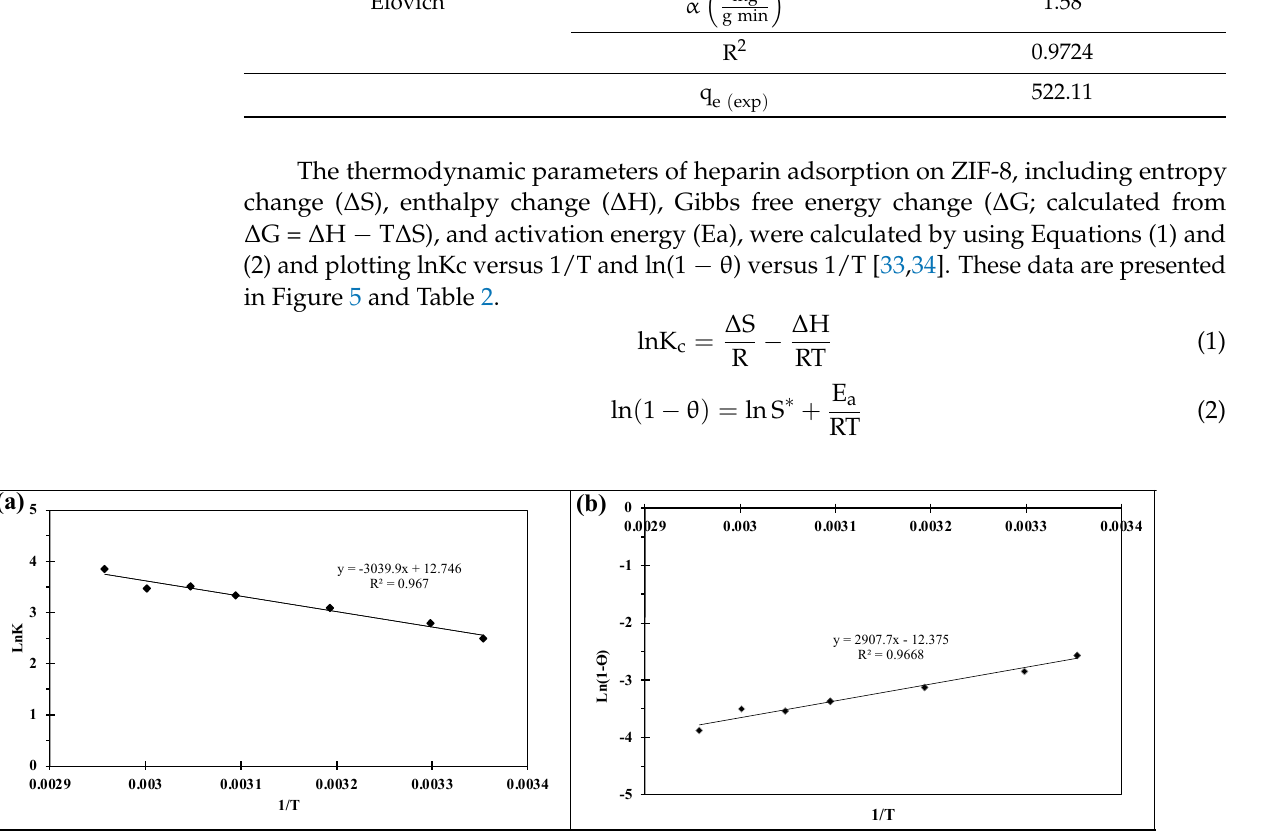
Figure 5. Thermodynamic study of heparin adsorption over ZIF-8 via ( a ) lnK vs. 1/T and ( b ) ln(1 − θ) versus 1/T. Table 2. Calculated thermodynamic parameters of heparin adsorption over ZIF-8.